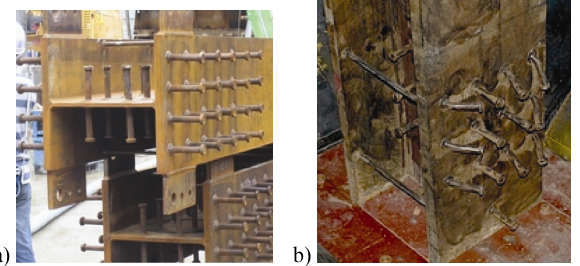
Fig. 2. Headed studs damaged by excavators during excavation: (a) before excavation and (b) after